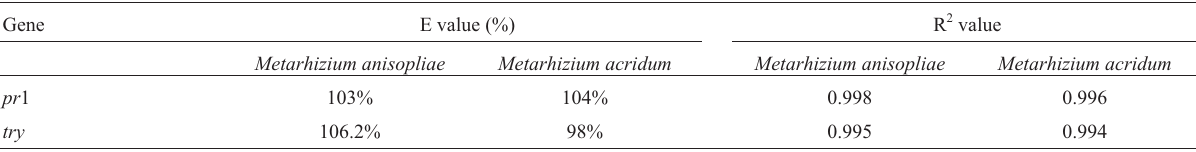
E = efficiency value; R 2 = regression coefficient